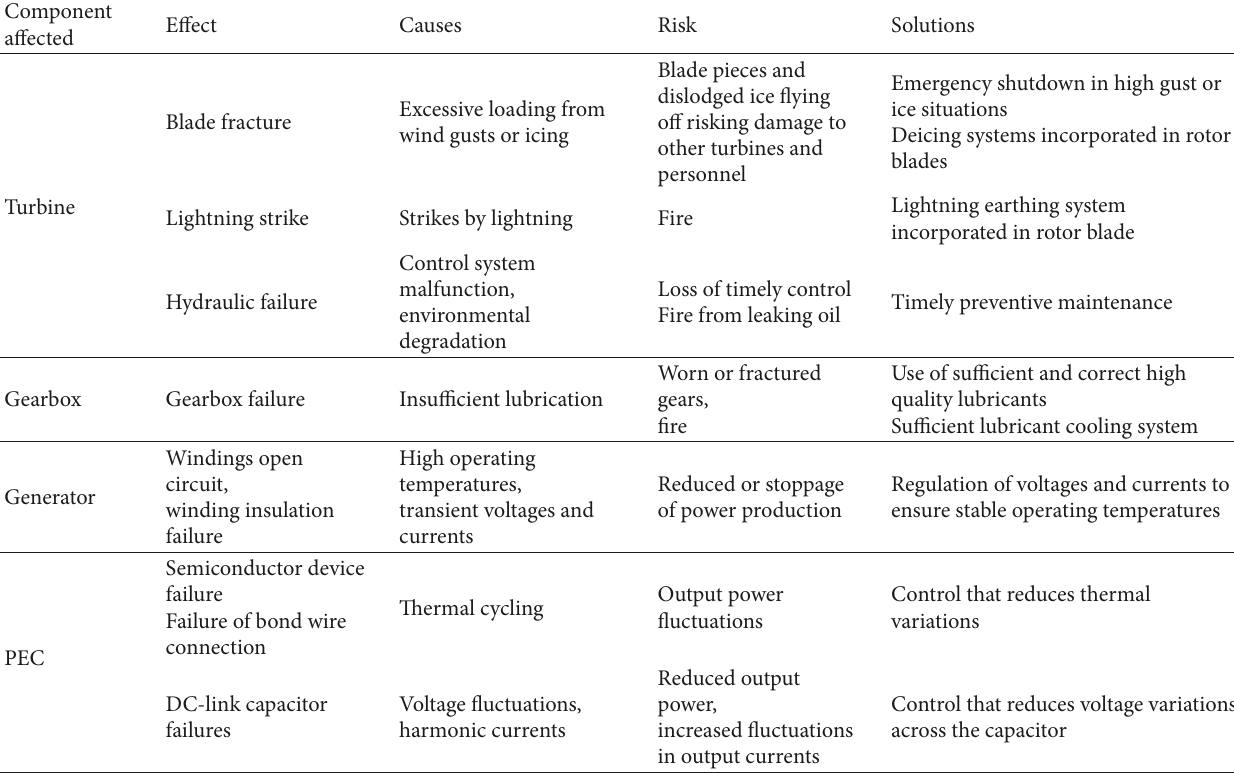
Table 1: DFIG WECS internal faults, their effects, and proposed